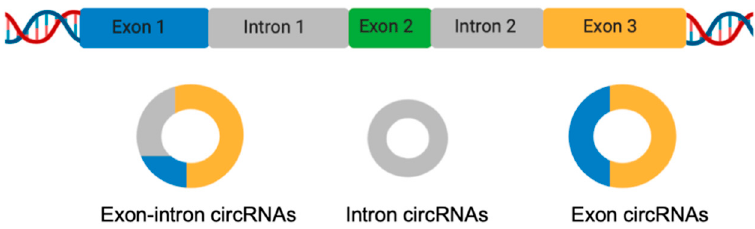
Figure 2. Schematic representation of circular RNA (circRNA) biogenesis.